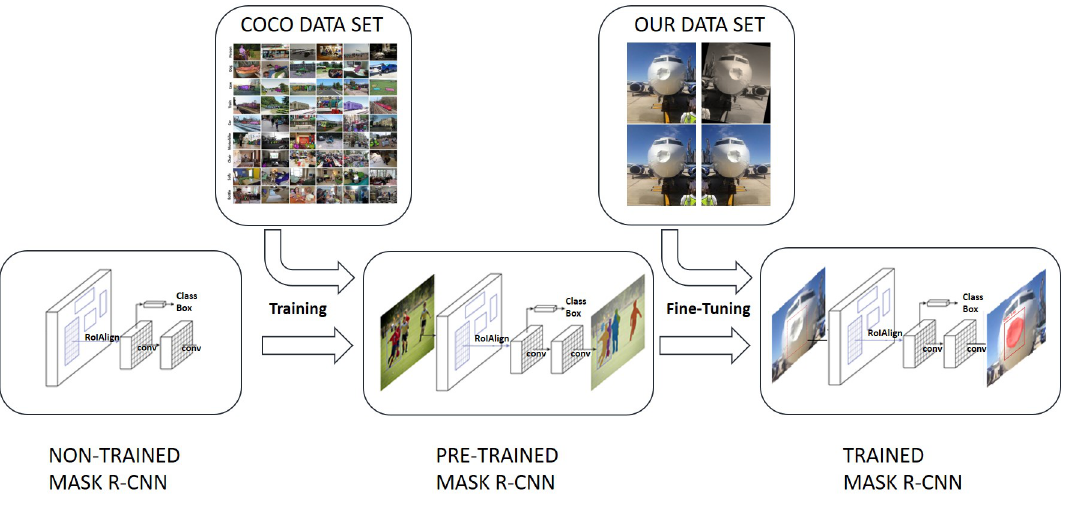
Figure 2. Transfer learning applied in the MASK R-CNN